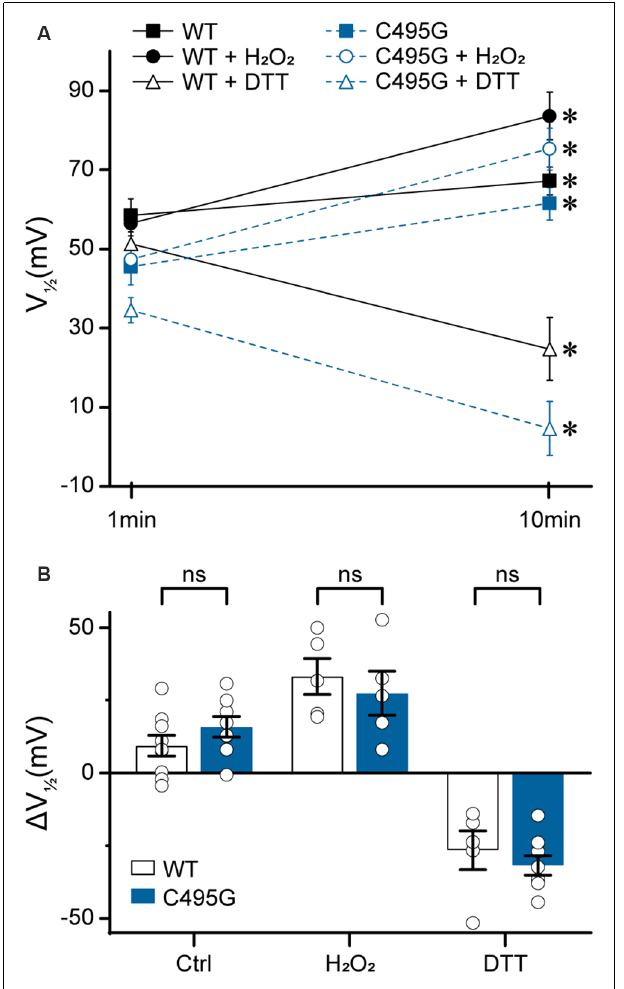
FIGURE 9 | Effect of residue 800 size and charge on regulation of BK current activation. Experiments were performed on the hBK VYR splice variant background in symmetrical K + solutions. (A) G–V relationships between WT and channels containing R800 substitutions (R800A, R800E, R800F, R800Q, and R800W) at 1- µ M Ca 2 + . Voltage protocols were identical to those in Figure 2 . (B) V 1 / 2 vs. Ca 2 + plot for WT and SNP-containing channels at 1- and 10- µ M Ca 2 + . Compared with WT, R800W exhibited a right G–V shift at 1- ( P < 0.0001) and 10- µ M Ca 2 + ( P < 0.0001), while all other R800 substitutions exhibited a left G–V shift at 1- (R800A, P = 0.002; R800E, P < 0.0001; R800F, P < 0.0001; R800Q, P < 0.0001) and 10- µ M Ca 2 + (R800A, P = 0.02; R800E, P = 0.06; R800F, P = 0.0002; R800Q, P = 0.007). ∗ P < 0.05, one-way ANOVA with Bonferroni post hoc test comparing V between WT and all R800 substitution constructs at each Ca 2 + condition. N = 5–21 recordings per construct per Ca 2 +